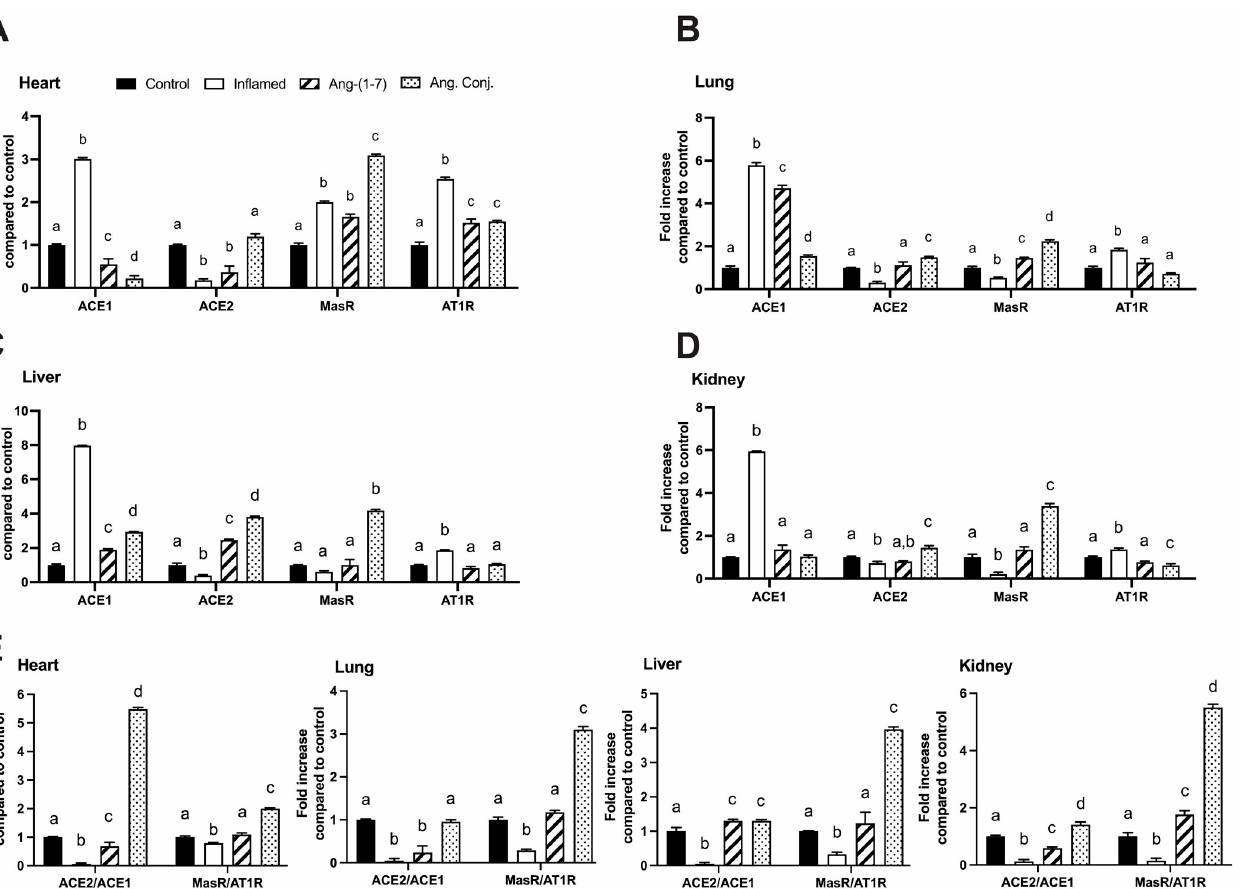
Figure 5. Gene expression of ACE1, ACE2, MasR, and AT1R levels in the heart ( A ), lung ( B ), liver ( C ), kidney ( D ) tissues, and the ratio of ACE2/ACE1 and MasR/AT1R in those tissues ( E ) in control ( n = 6), inflamed ( n = 6), Ang-(1-7)-treated ( n = 5), and Ang. Conj.-treated ( n = 5) groups. ACE1—angiotensin-converting enzyme 1, ACE2—angiotensin-converting enzyme 2, MasR—Mas receptor, AT1R—angiotensin II type 1 receptor. The values are reported as mean ± SEM, and statistical analysis was done using one-way ANOVA with the Tukey multiple comparison post-hoc test. Groups labeled with different letters have significant differences between them ( p < 0.05).